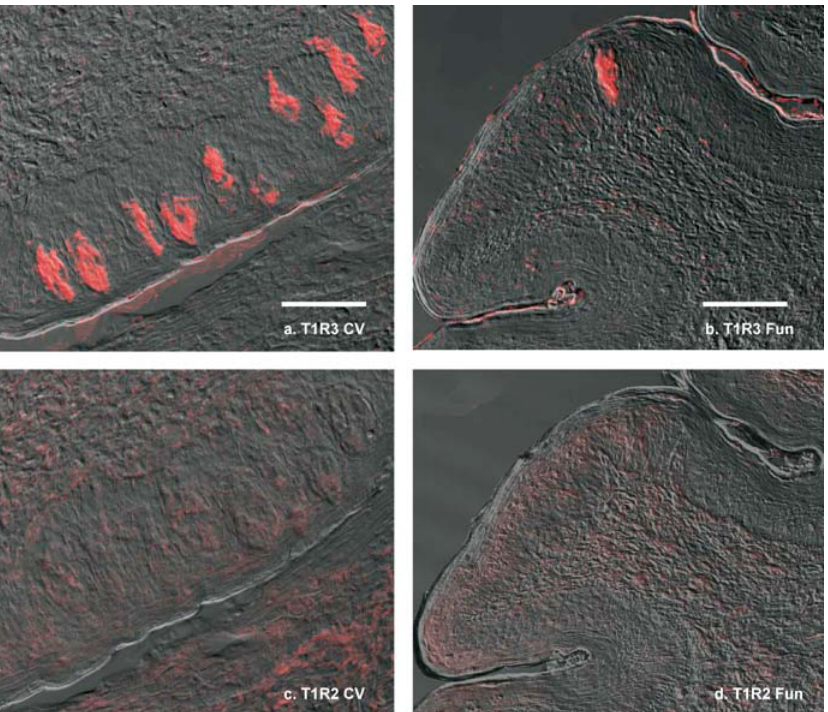
Figure 4. Protein Expression of Cat T1R2 and T1R3 Cat T1R3 expression is detected in taste buds of circumvallate papilla (CV) (A) and a fungiform papilla (Fun) just anterior to the intermolar eminence (B) by labeling with anti-mouse T1R3 antibody. Cat T1R2 expression is not detectable in either circumvallate (C) or fungiform (D) using an anti-cat T1R2 antibody. Control studies demonstrated that the anti-cat T1R2 antibody labeled a subset of taste bud cells in rat circumvallate (data not shown). Scale bar, shown only in panel (A) and (B), = 60 l m for (A) and = 45 l m for (B). Scale for panel (C) is the same as that of panel (A); scale for panel (D) is the same as that of panel (B). DOI: 10.1371/journal.pgen.0010003.g004